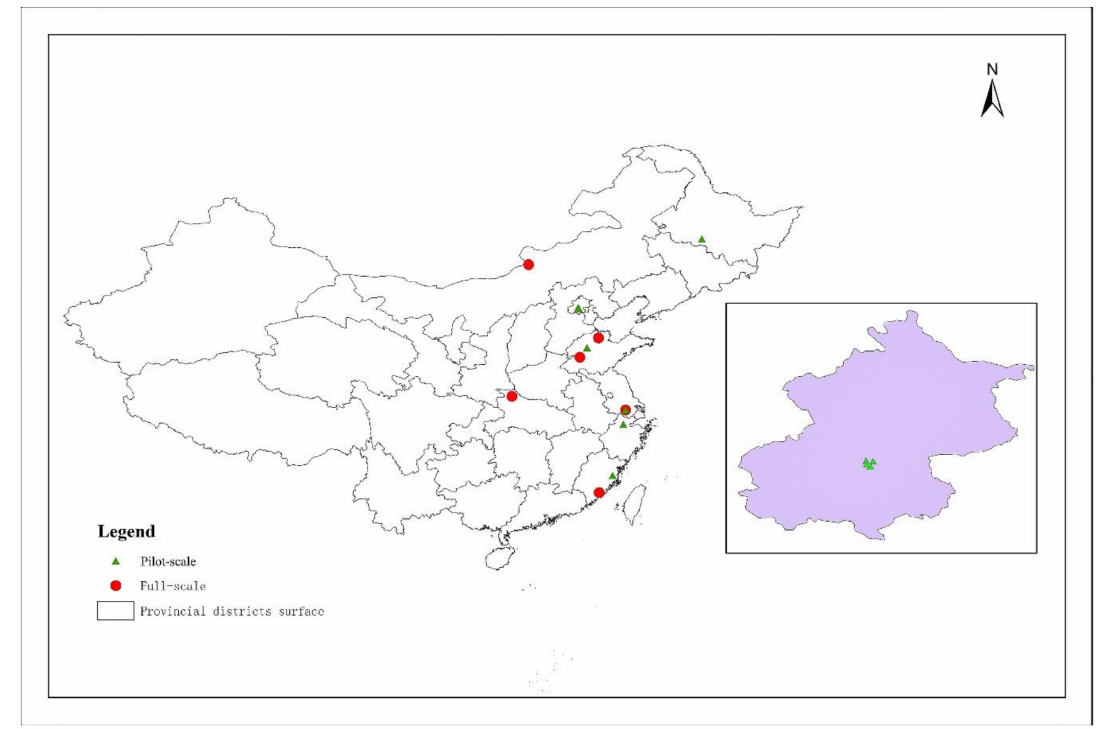
Figure 3. Geographical distribution of pilot-scale and full-scale anammox plants in